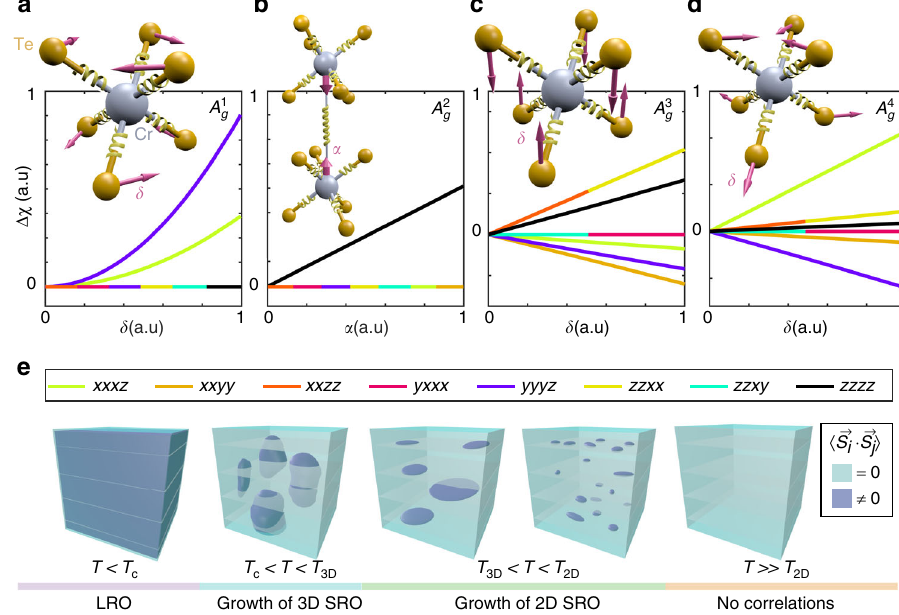
) under totally symmetric distortions along the a , A 1 , b , A 2 , c , A 3 and g g g ijkl